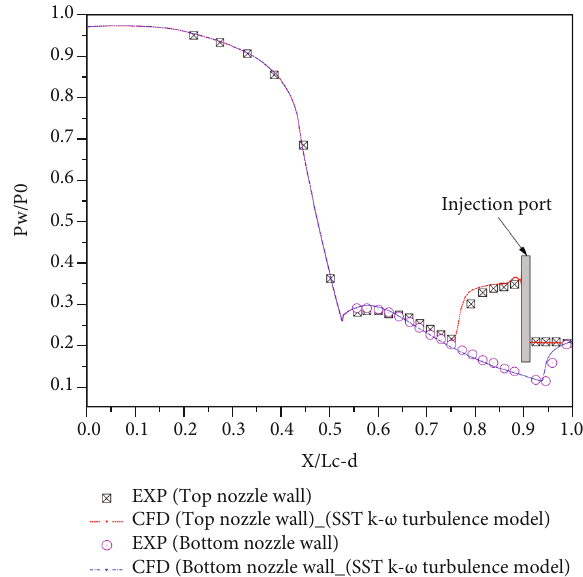
Figure 5: Experimental validations of static pressures along wall surfaces ( NPR = 4 : 6 ).